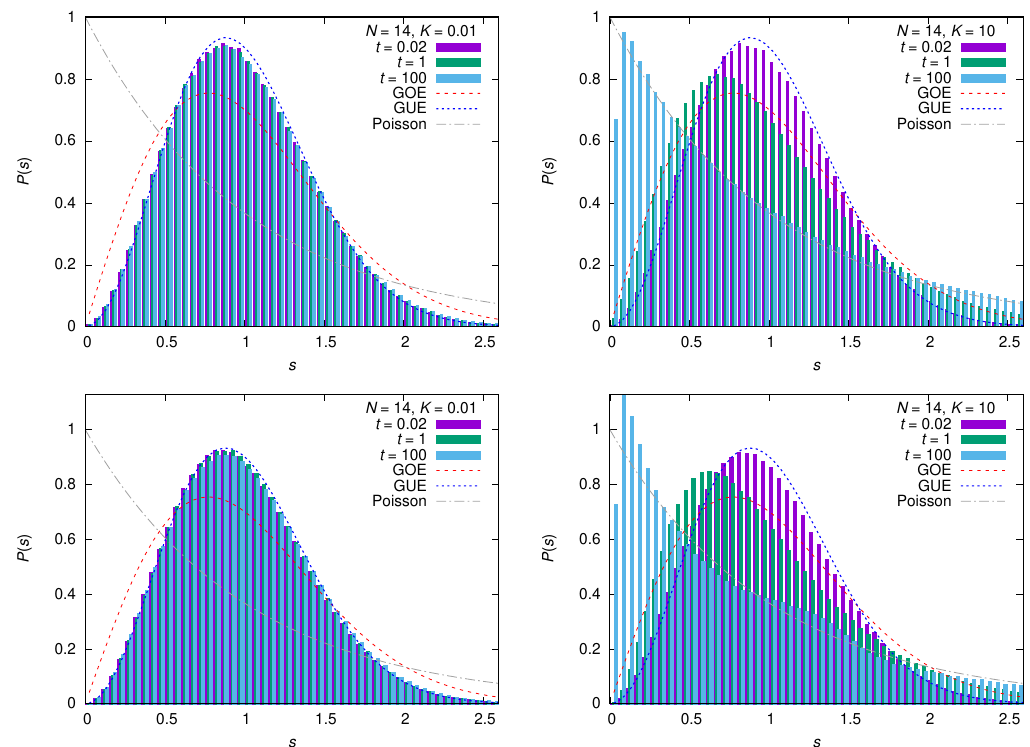
Figure 16 . Nearest neighbor correlation for the unfolded Lyapunov spectrum of the generalized Majorana SYK model, N = 14, (cid:12) = 0, 0 : 02 (cid:20) t (cid:20) 100 with K = 0 : 01 ; 10. [Upper] standard unfolding is conducted by (cid:12)tting the density of exponents using a polynomial. [Lower] The (cid:12)xed- i unfolding has been performed. When K is small, good agreement with GUE is observed, until very late time. When K is large, small deviation from GUE can be seen at early time, and the deviation grows quickly at later